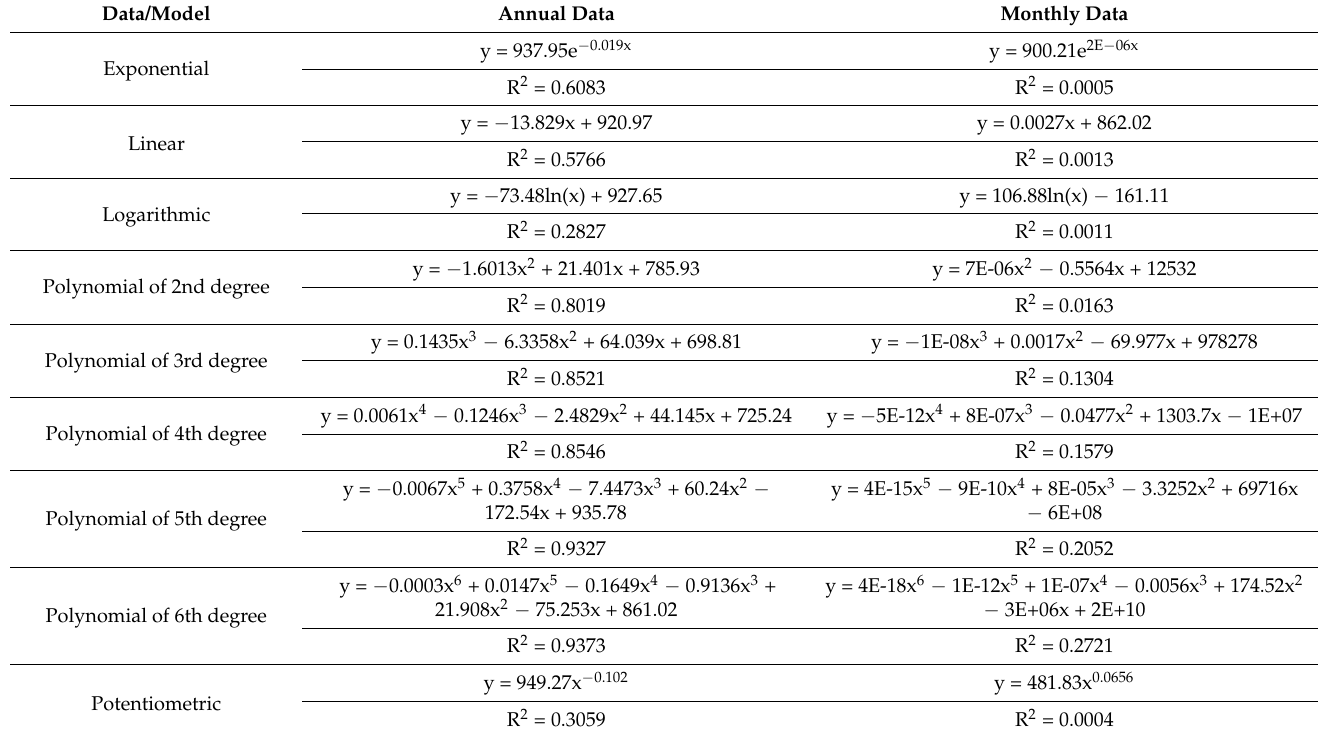
Table A4. Trend models for Lubuskie province.